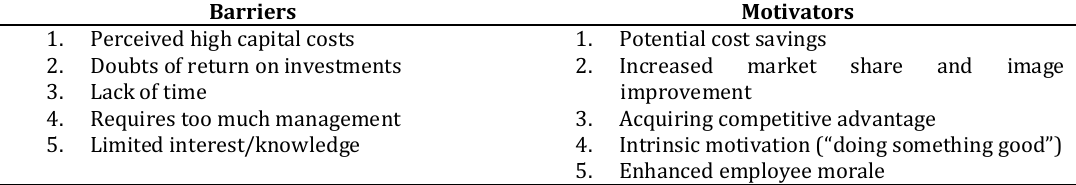
Table 3: Five barriers and motivators for recycling and reducing plastic